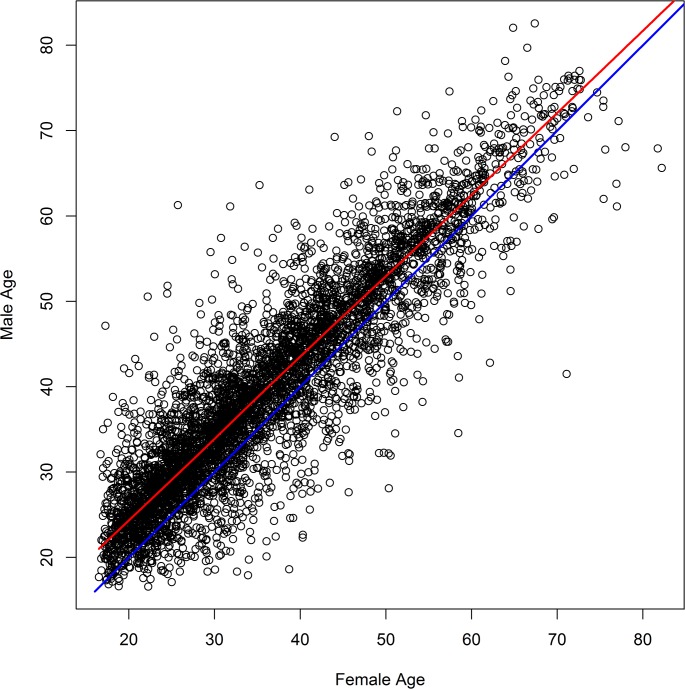
Ages of sexually active males plotted against the age of their sexually active female partners.While the model allows for partnerships between people of different ages, the majority of people partner with someone who is about the same age after accounting for age-disparate relationships. The red line is a lowess fit to the data. The blue line is the y = x line that would occur if women partnered only with men who were exactly the same age. This graph shows data from a simulation in which treatment had reduced incidence to zero.